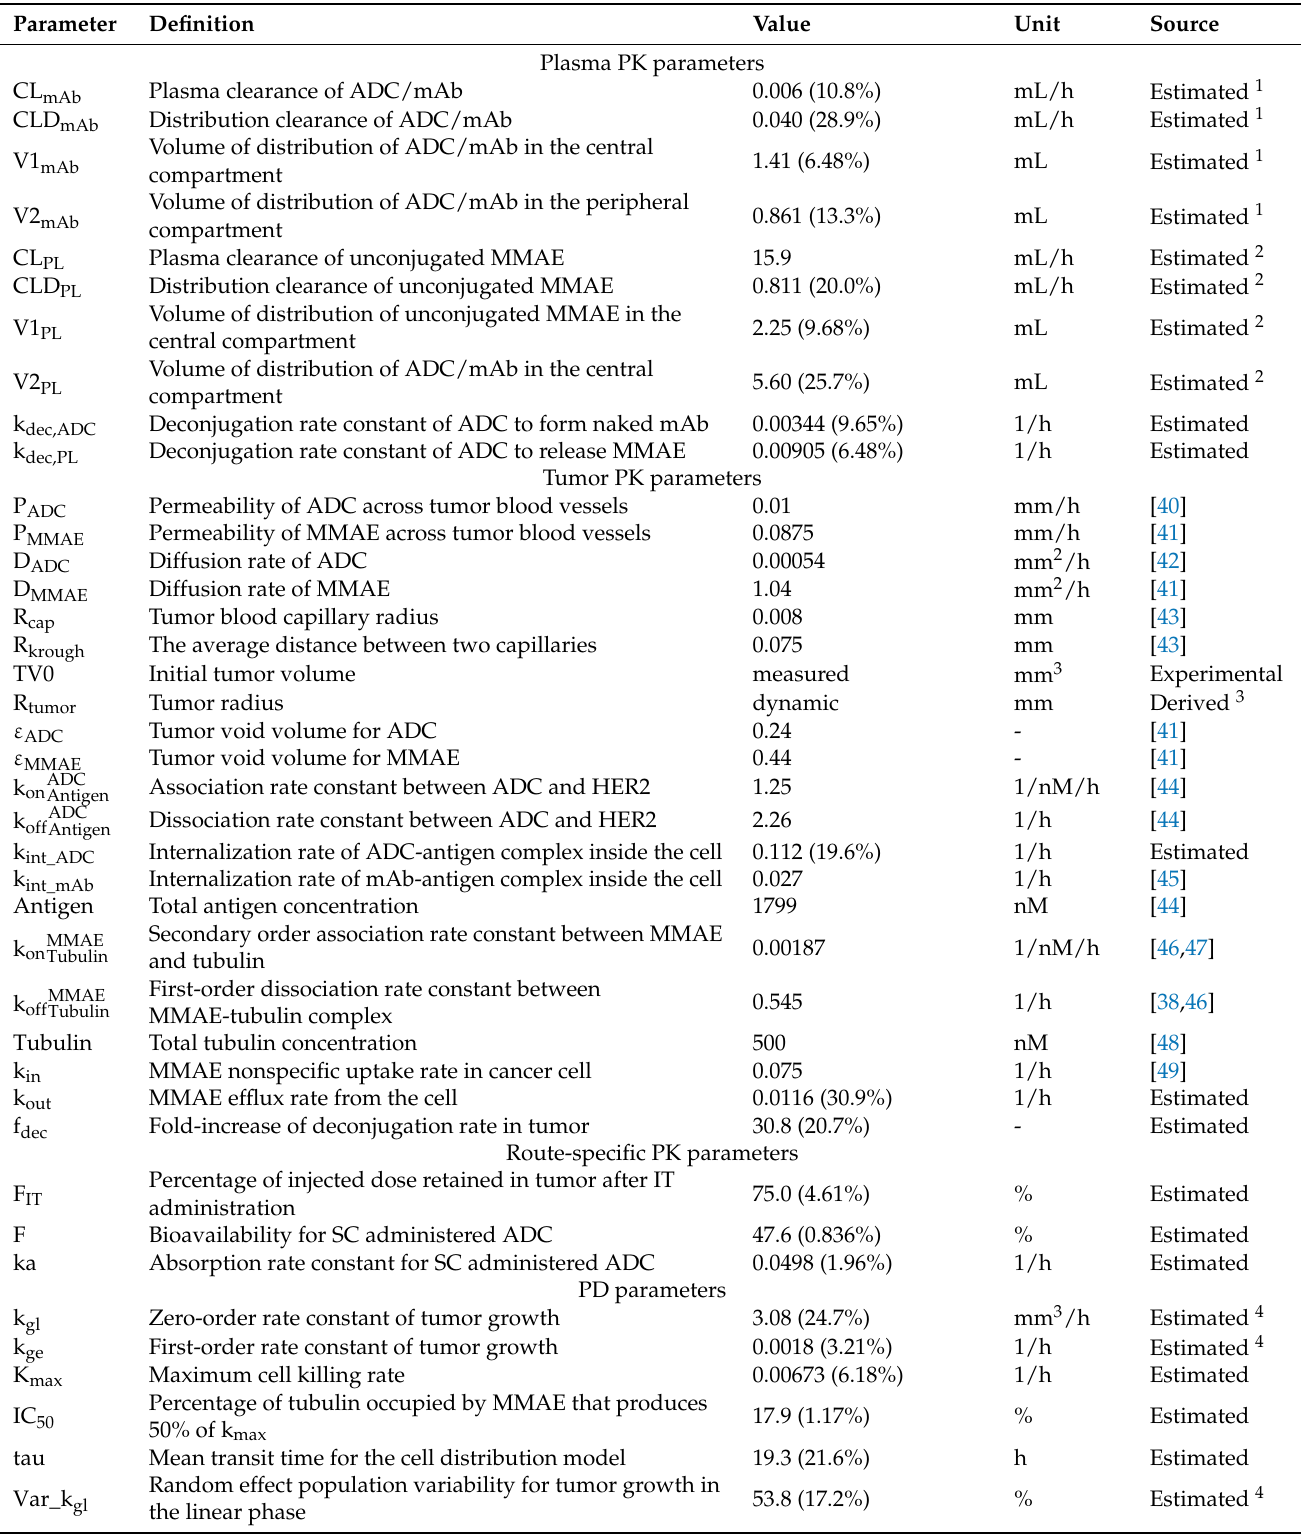
Table 1. A list of literature-derived or model-estimated parameters used by the semi-mechanistic PK/PD